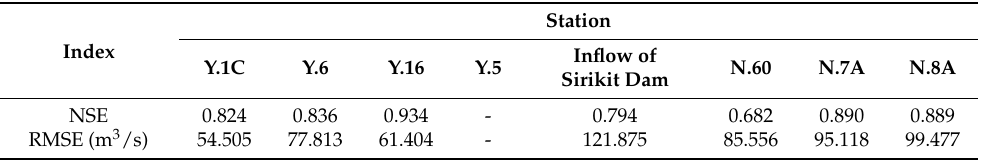
Table 2. Values of the Nash–Sutcliffe model Efficiency (NSE) and Root Mean Square Error (RMSE) for the calibration period (1997–2006).